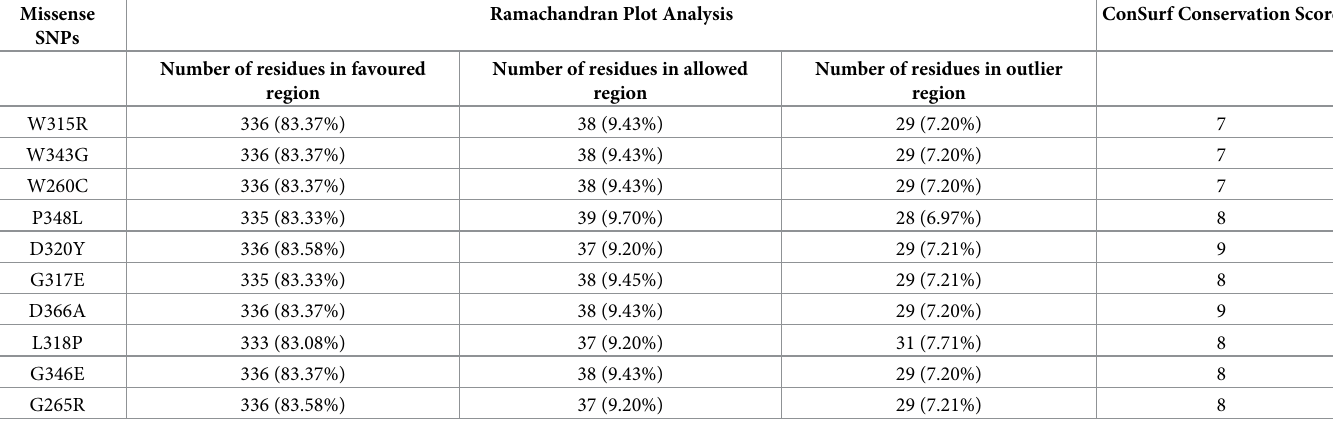
Table 6. Ramachandran analysis of all the mutated models in addition to evolutionary conservation score predicted by ConSurf. Missense